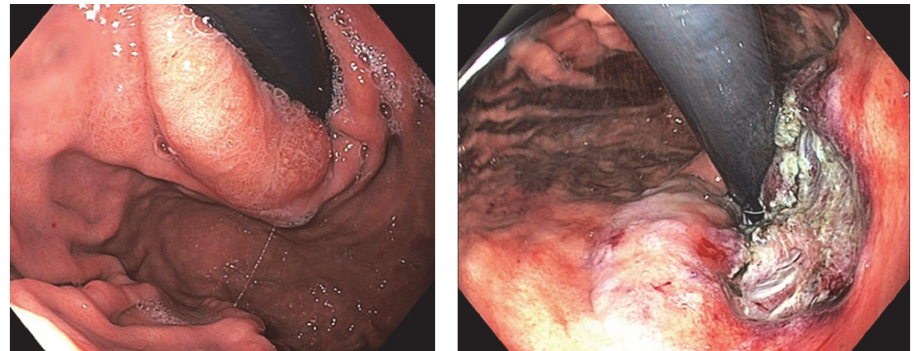
Figure 1: Endoscopic appearance before and after resection (retroverted view).